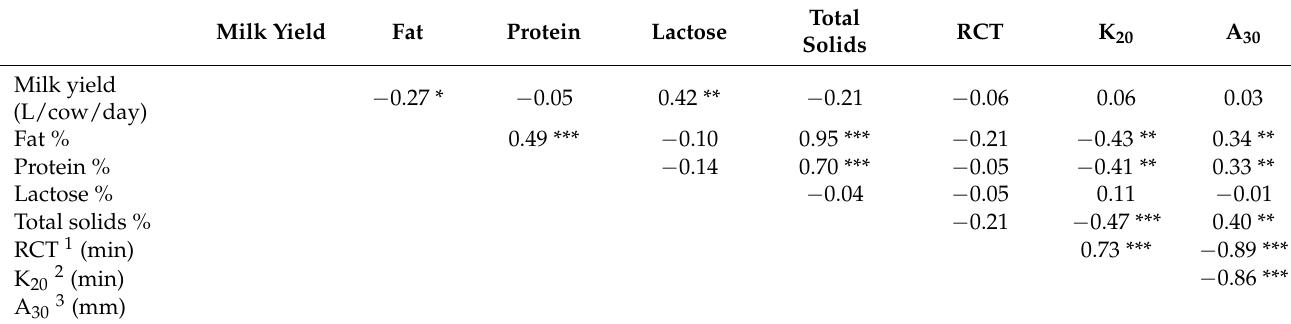
Table 7. Partial correlation coefficients between coagulation properties and milk components of cows (regardless of milking frequency and milking time) during the late lactation in the 2020–2021 production season.